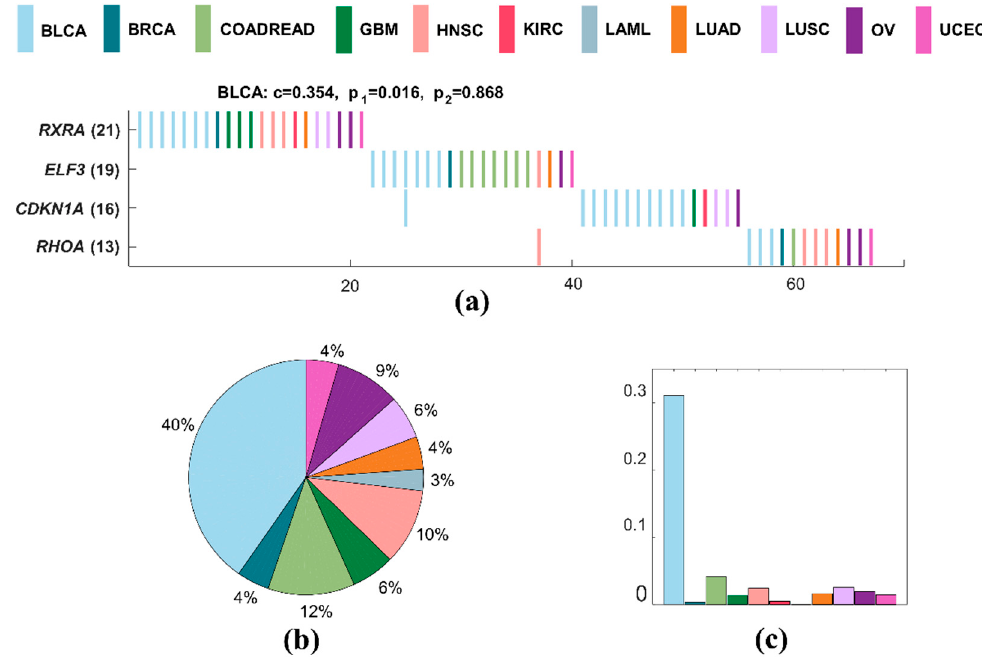
Figure 4. A specific driver module in BLCA. Different colors represent different cancer types. ( a ) Mutation matrix for the cancer specific driver module of BLCA. The genes on the left are the members in the specific driver module. The number behind the gene is the number of samples in which this gene is mutated. ( b ) The external coverage of the specific driver module in ( a ) for each cancer type. ( c ) The internal coverage of the specific driver module in ( a ) for each cancer type.